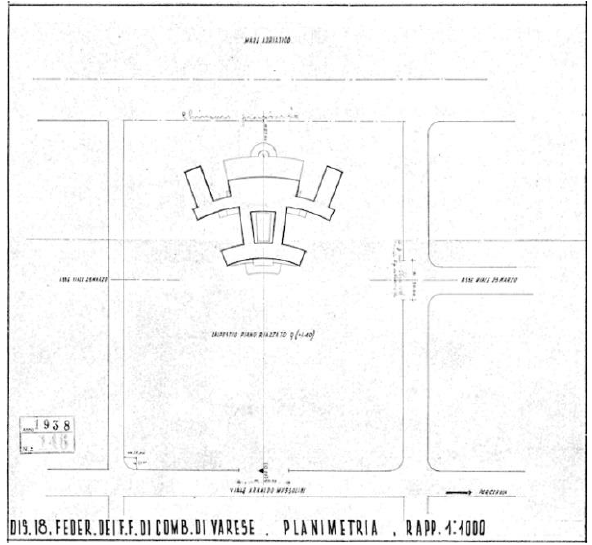
Figure 8 . Project drawing. Overall plan.